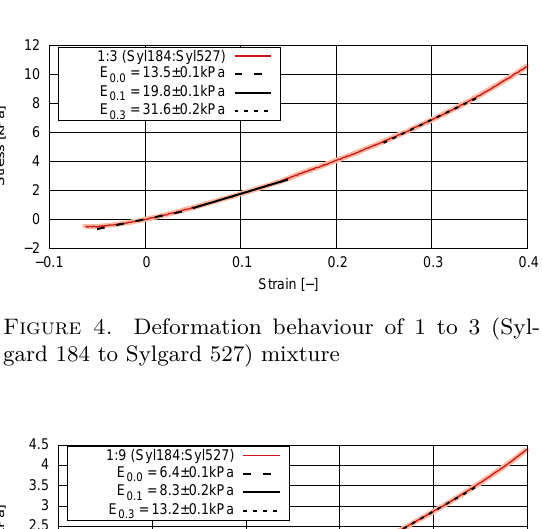
Figure 2. Detail of the compressed pure Sylgard 184 sample under 60 % deformation in loading chamber